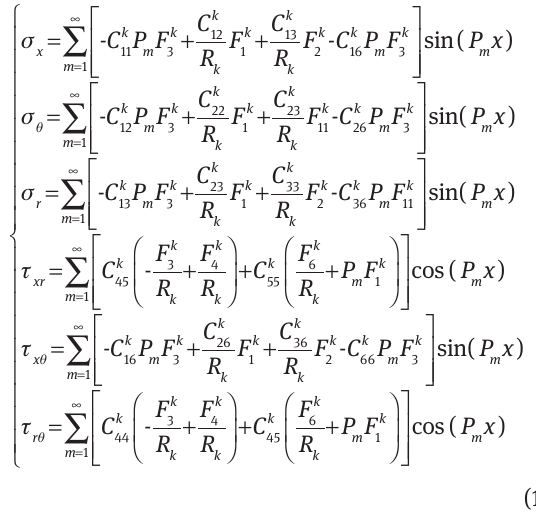
Table 2 Characteristics of the trained neural network used to model the natural frequency of the four-layer shell.